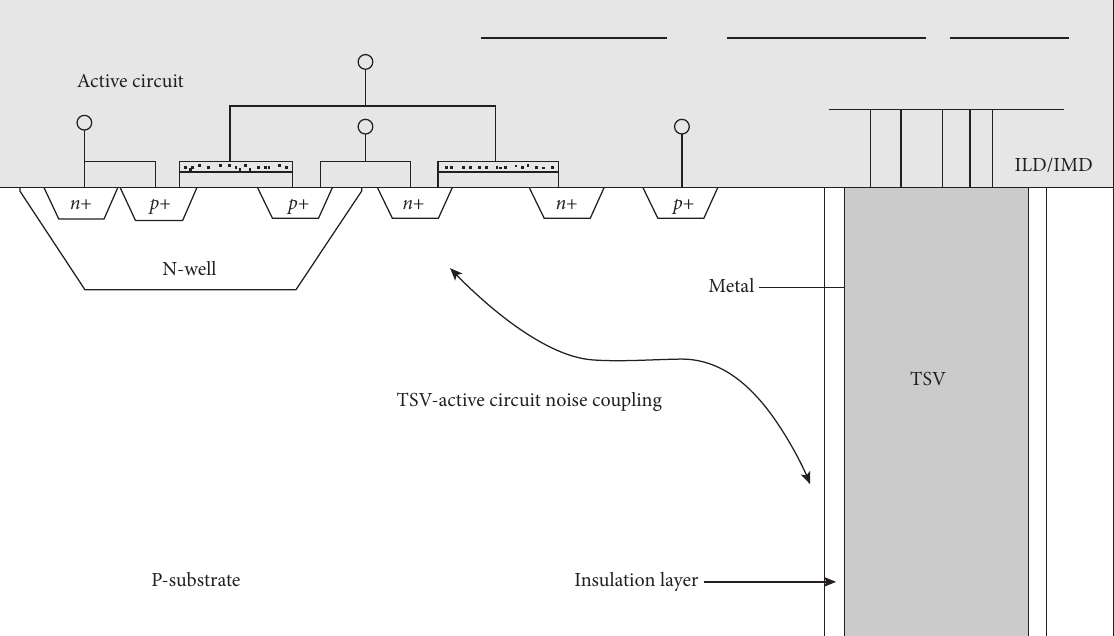
Figure 6: The conceptual view of TSV-active circuit noise